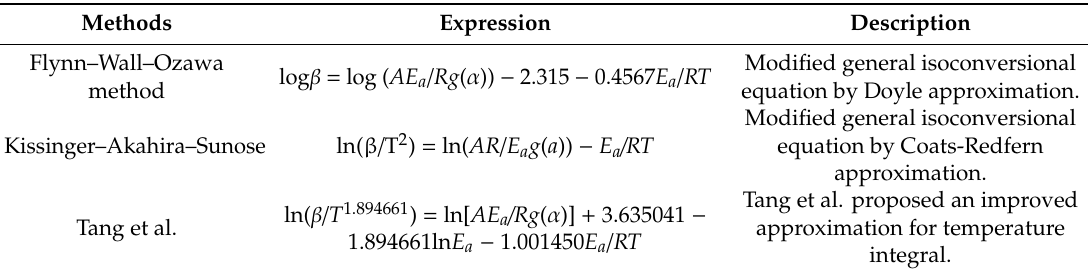
Table 1. Three commonly used isoconversional methods for activation energy